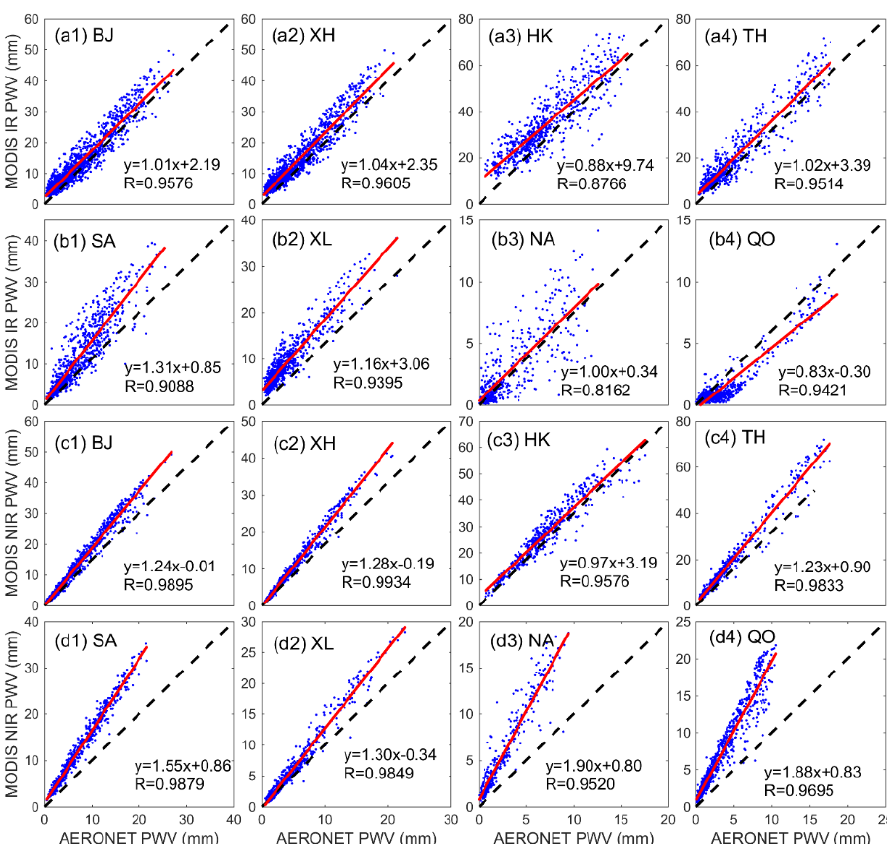
Figure 3. Scatterplots of the AERONET-derived versus MODIS-derived IR/NIR PWV values